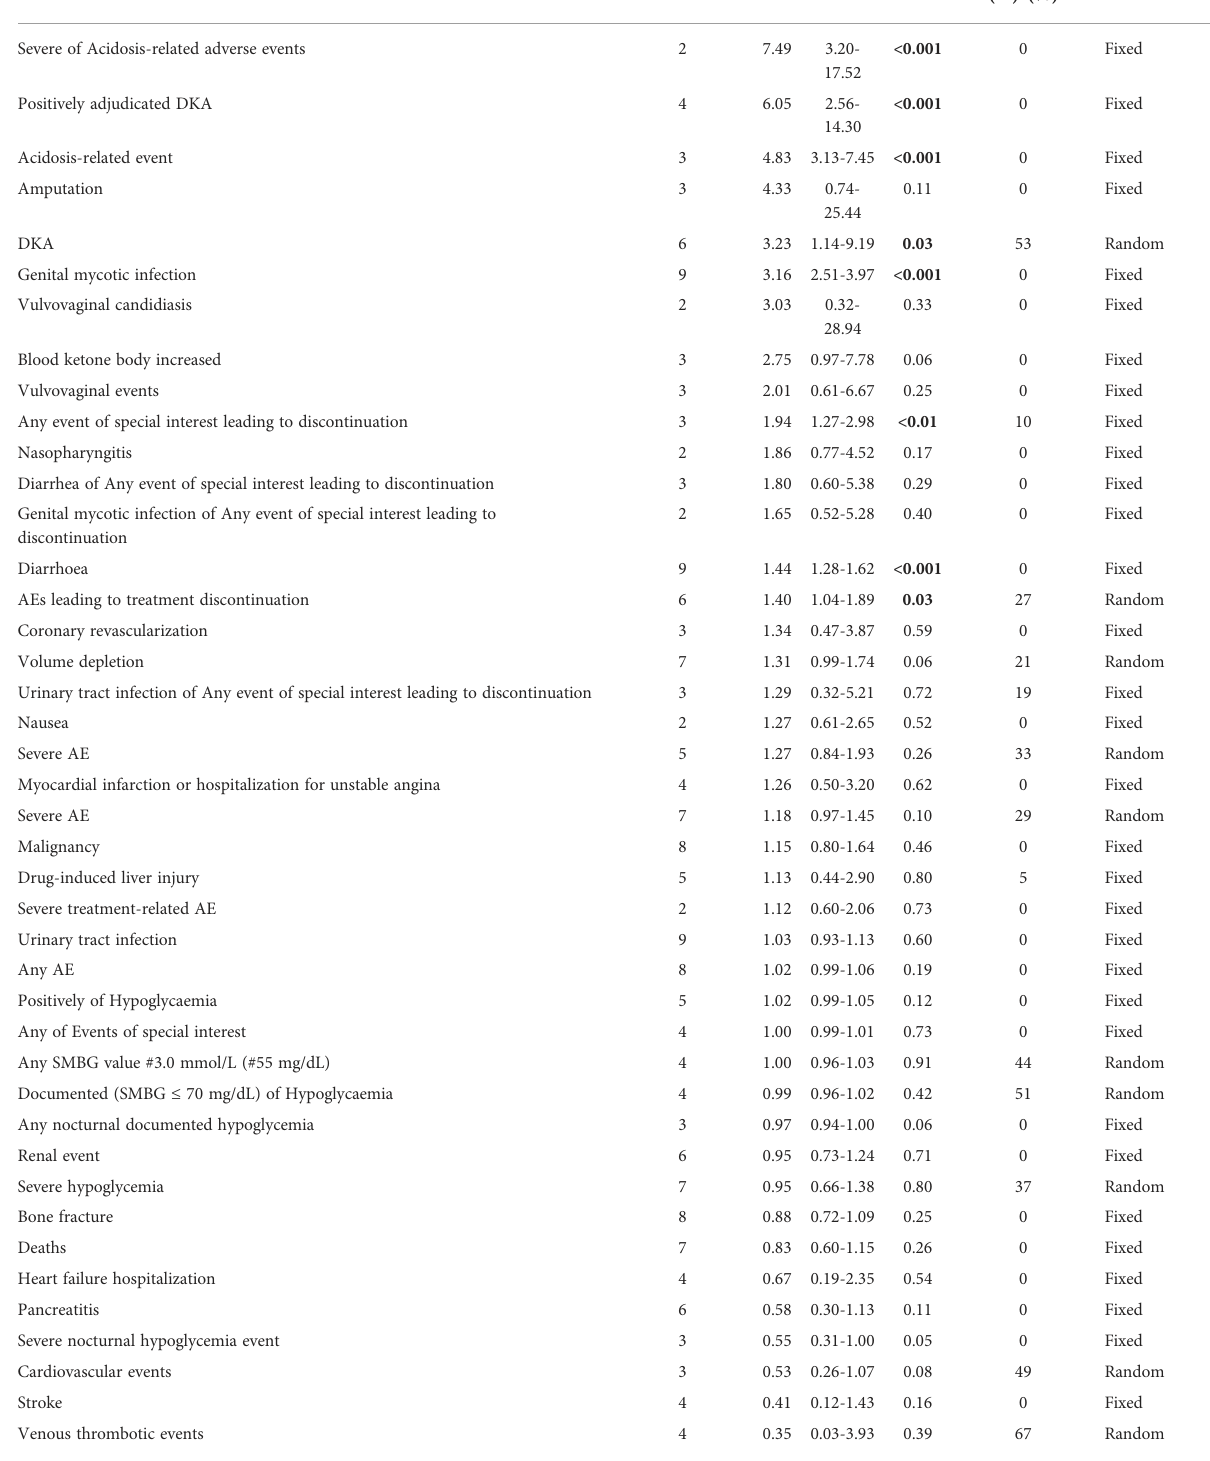
TABLE 1 Subgroup analysis of the adverse events (AEs). Experimental vs.